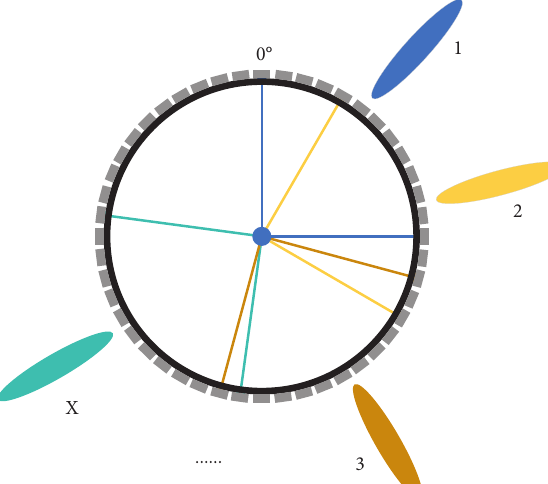
Figure 7: Multibeam forming of cylindrical array antenna based on overlapping array, and the subarray can be